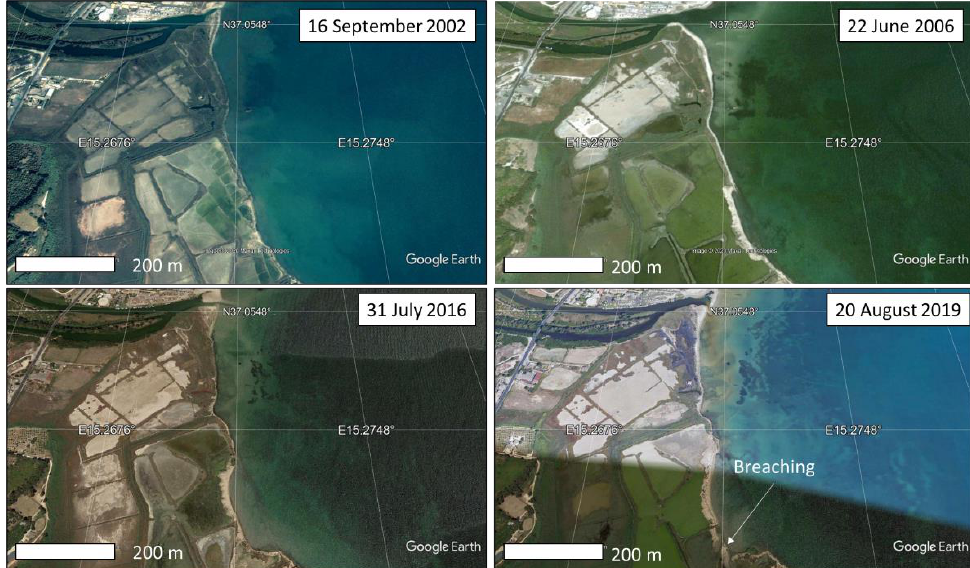
Figure 6. Multi-temporal shoreline changes observed along at the mouth of Ciane river in the time span 16 September 2002–20 August 2019. In 2019, the southern sector of the beach has been affected by a foredune breaching. In 17 years, the coast retreated up to 70 m due to the effect of RSLR with a loss of surface of 0.07 km 2 .